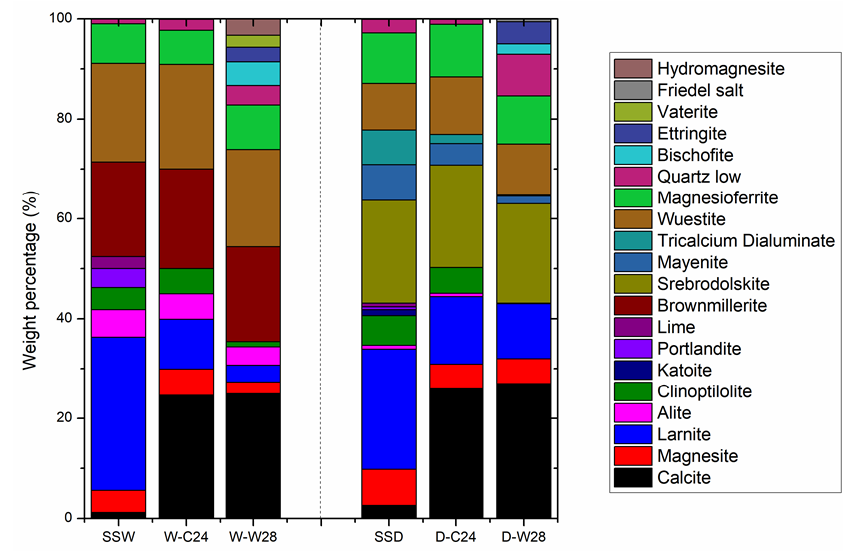
Figure 7. QXRD Analysis on the representative